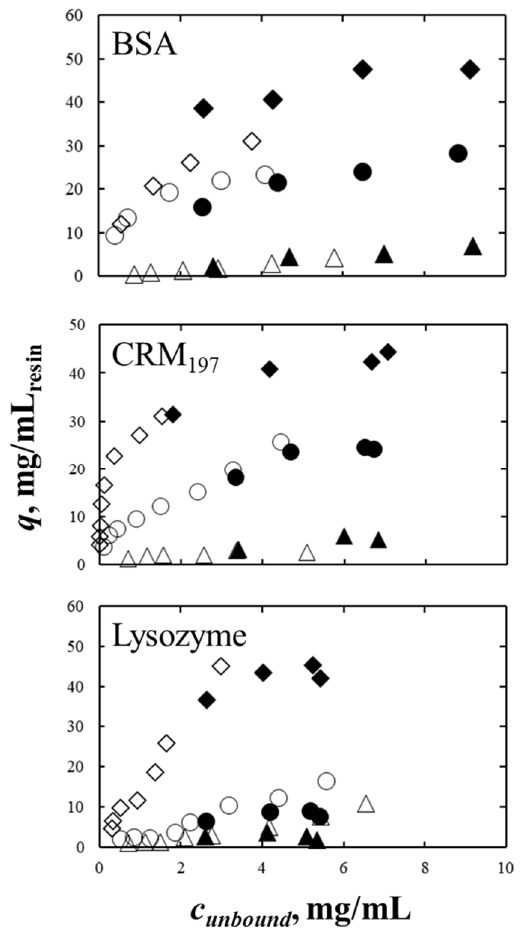
Figure 2. Comparison of high-throughput (open symbols) and breakthrough (filled symbols) experimental isotherms for BSA, CRM 197 and Lysozyme. Breakthrough data were corrected for CF to be consistent with high-throughput data. In the case of BSA and Lysozyme, triangles, circles, and diamonds represent, respectively, 0, 1, and 1.5 mol/L of ammonium sulfate in the buffer. In the case of CRM 197 , the salt concentrations investigated and compared are 0.25, 0.75, and 1.2 mol/L, represented by, respectively, triangles, circles, and diamonds.